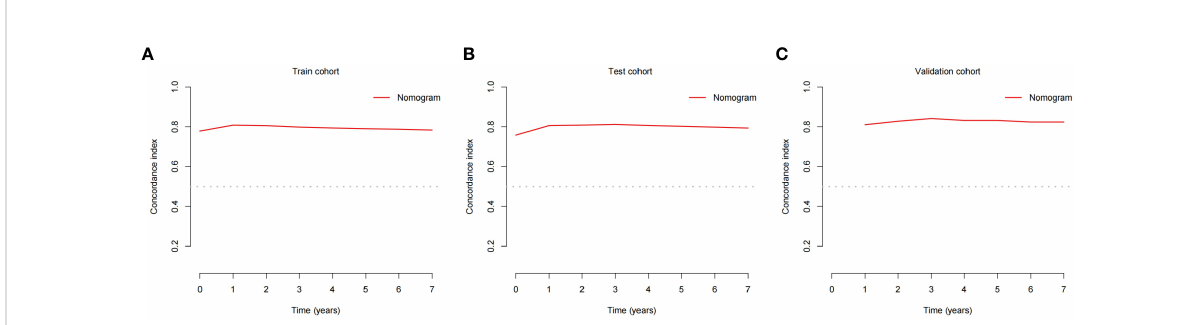
FIGURE 3 C-indexes for the nomogram in patients with GEP-NECs. (A) C-index for the nomogram in the train cohort. (B) C-index for the nomogram in the test cohort. (C) C-index for the nomogram in the validation cohort. C-index, concordance index; GEP-NECs, gastroenteropancreatic neuroendocrine